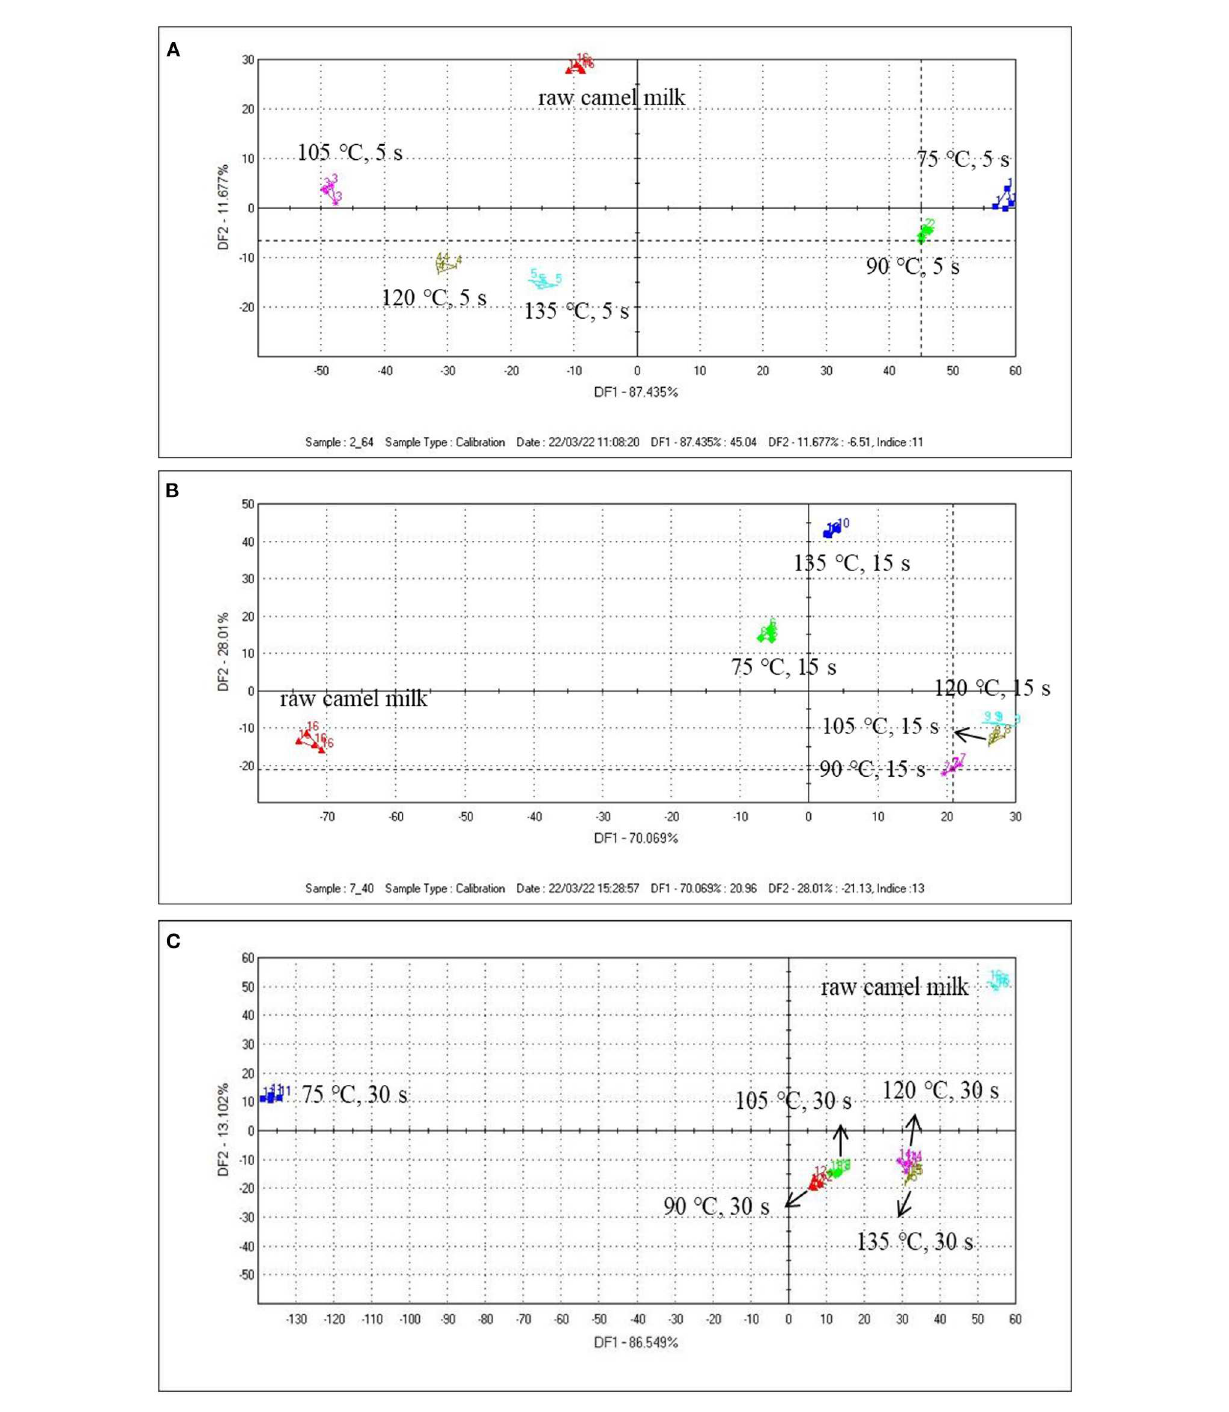
FIGURE2 The DFA results of the electronic tongue data from camel milk samples heated at different temperatures for 5s (A) , 15s (B) , and 30s (C) .